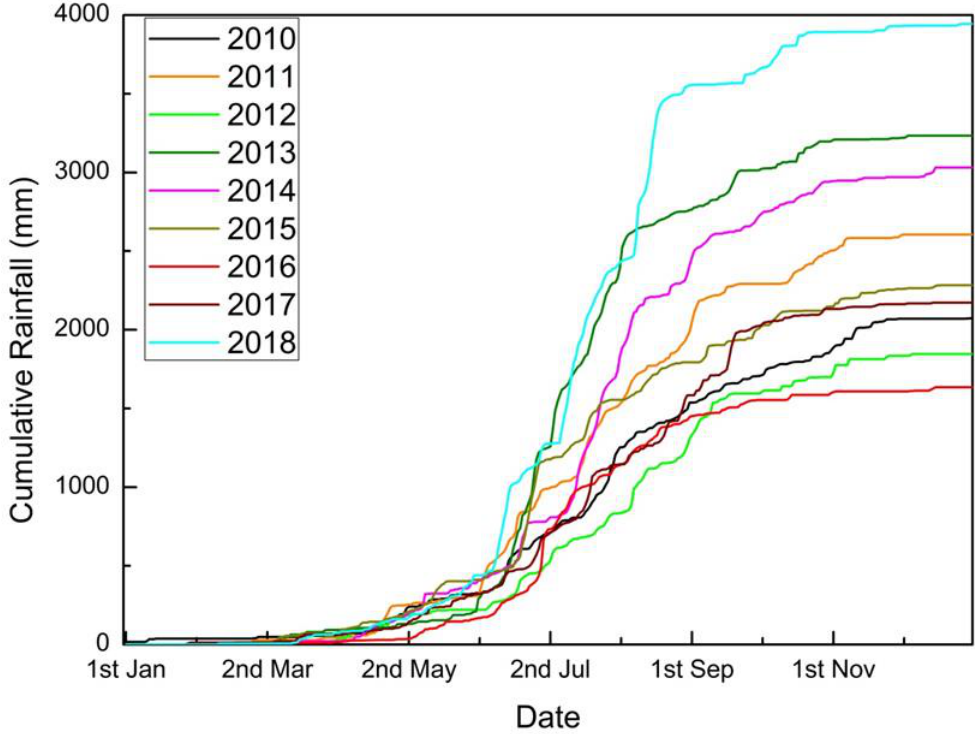
Figure 4. Annual cumulative rainfall during the study period—district average values.